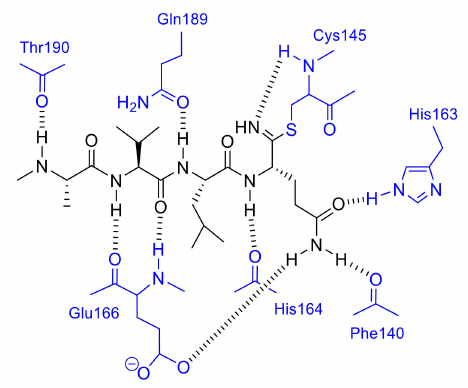
Figure 8. Interactions of the nitrile-based inhibitor with SARS-CoV 3CL pro .